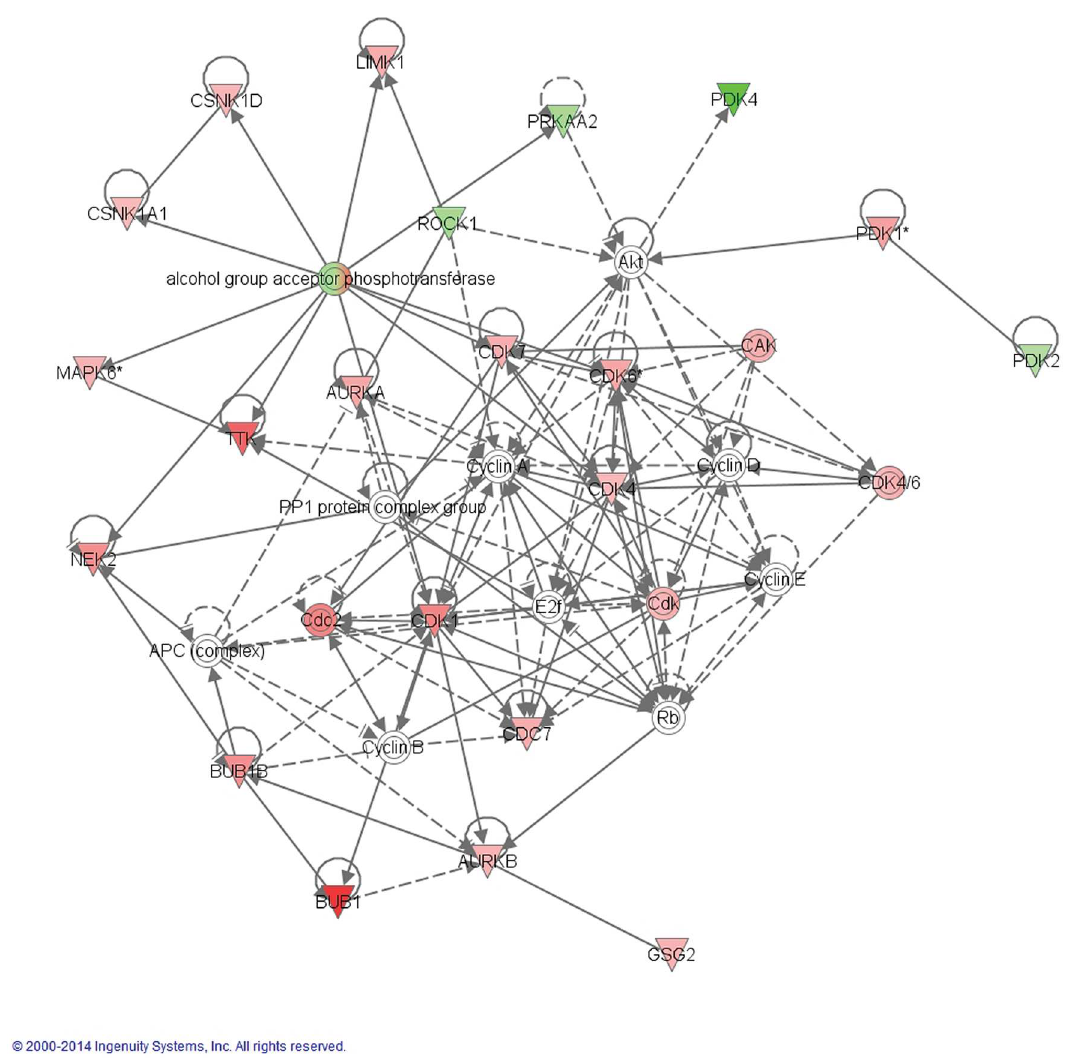
Fig 2. Ingenuity pathway analysis of differentially expressedkinases in primary PDAC compared to normal pancreasidentified by unbiased methods. All 106 differentially regulatedkinases were analyzedby integratedpathway analysisusing IPA. The posttranslational modificationcell cycle, cellularassembly and organization, one of the most dominantnetworks, is depictedhere. Signalingpathwaysare coloredaccordingto expression, green representingdown- regulationand red representingup-regulation with the expressionfold changerepresentedby more intensecolors.